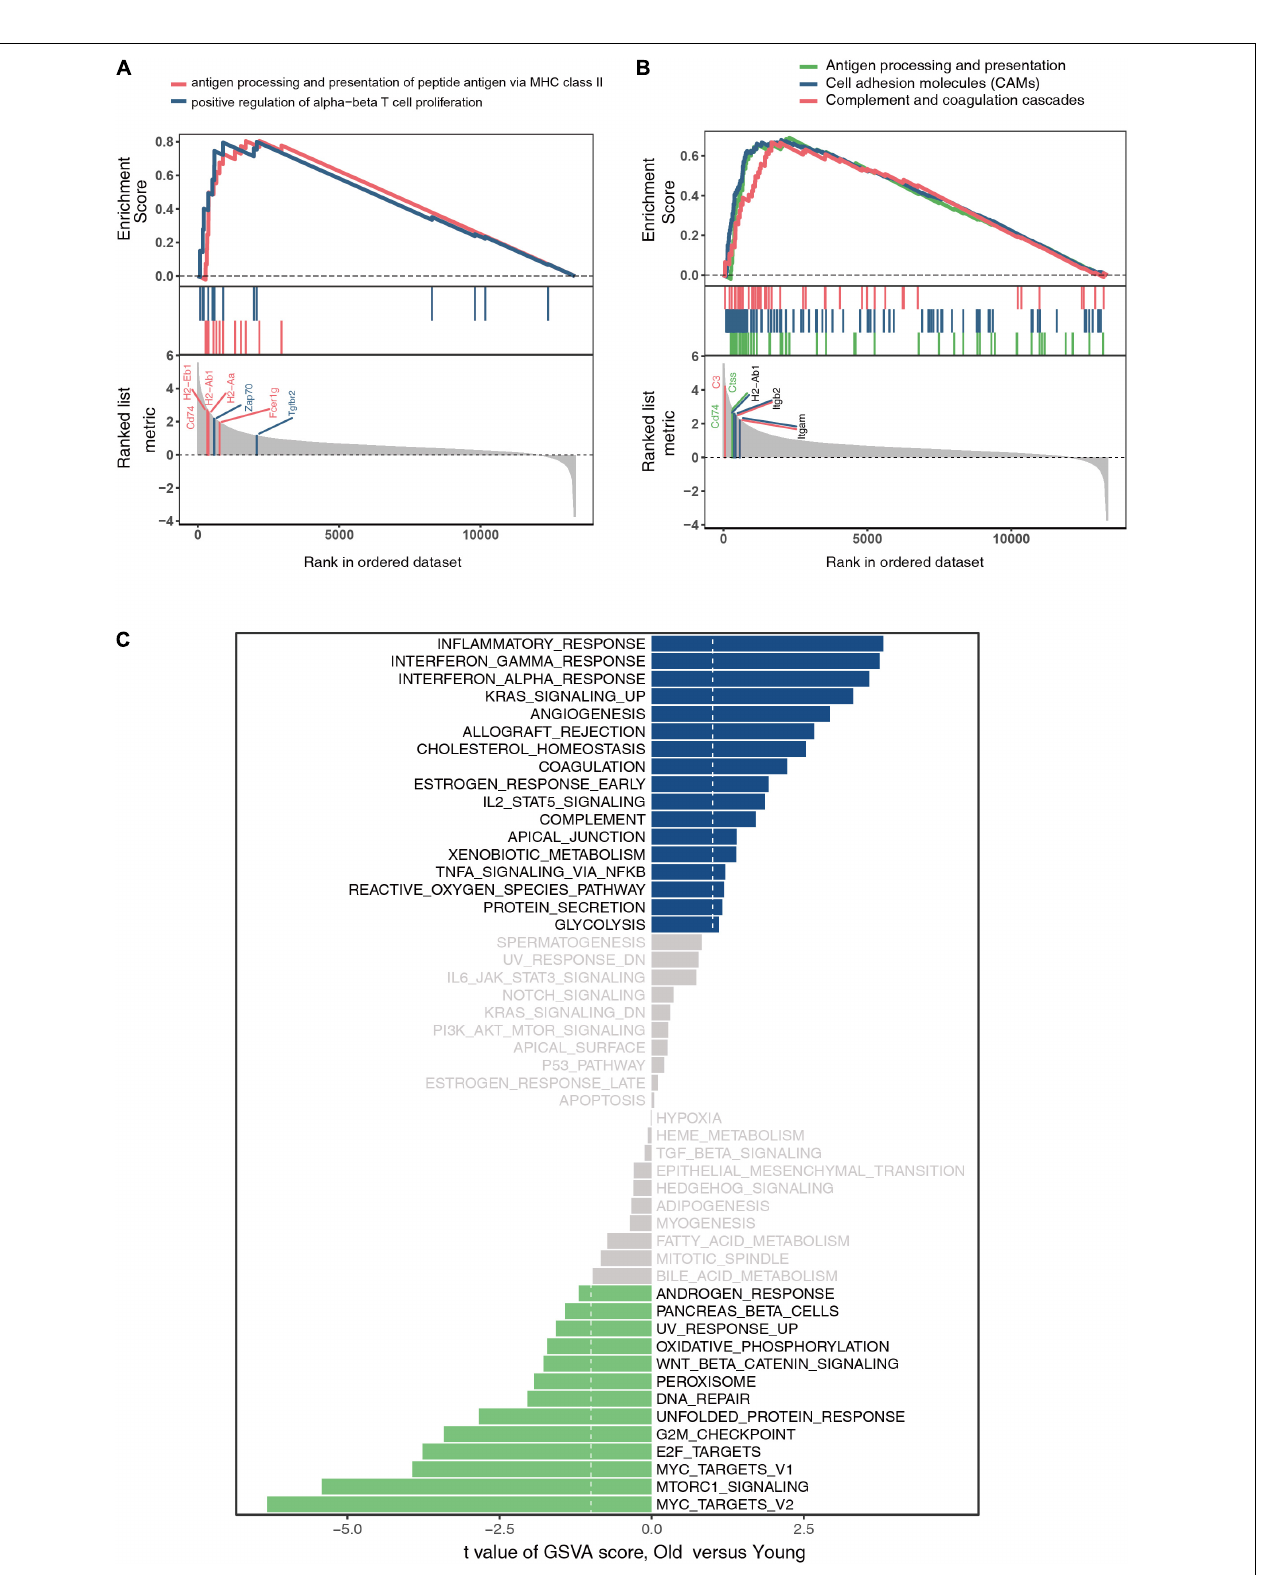
Frontiers in Genetics |